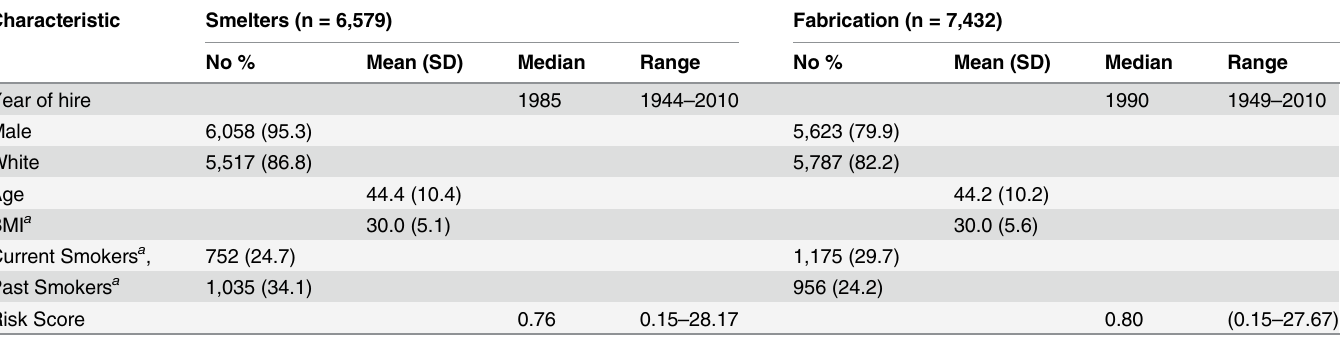
Abbreviations: BMI = body mass index; SD = standard deviation